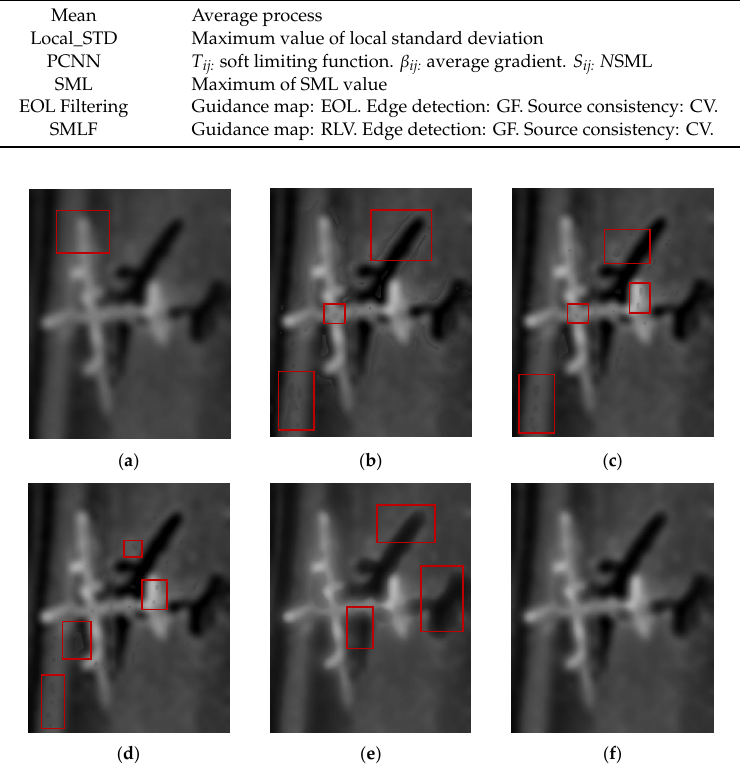
Figure 7. Low frequency sub-band images with different fusion criteria in Data 1. ( a ) Mean. ( b ) Local_STD. ( c ) PCNN. ( d ) SML. ( e ) Energy of Laplacian (EOL) filtering. ( f ) SMLF.